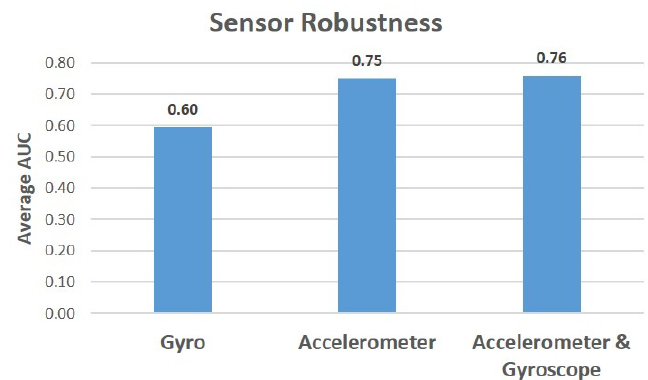
Figure 7. Average AUC results of the AdaBoost and Gradient Boosting classifiers based on measure- ments that were obtained from a single sensor and from both